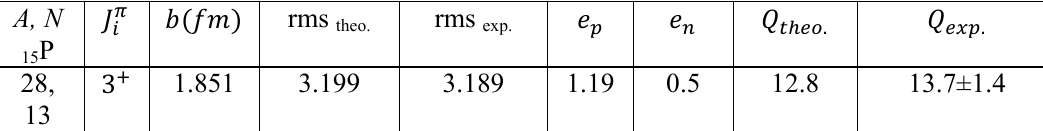
Table 3: Quadrupole moments in units of (cid:2187) (cid:2188)(cid:2195) (cid:2779) calculated with harmonic oscillator (HO) potential for Phosphorus (P) isotopes (Z = 15). Effective proton and neutron charges are deduced from the core polarization calculation. Experimental quadrupole moments are taken from Ref.